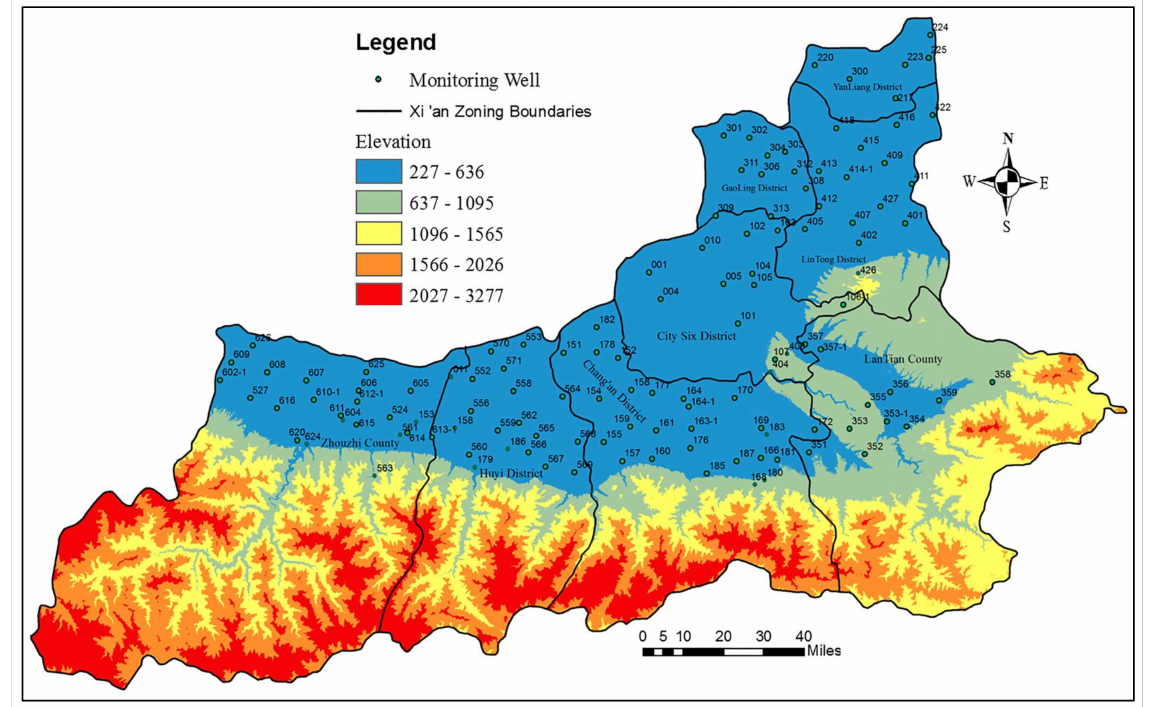
Figure 1. A distribution map of Xi’an shows the distribution of the landform, administrative division, and groundwater monitoring well.